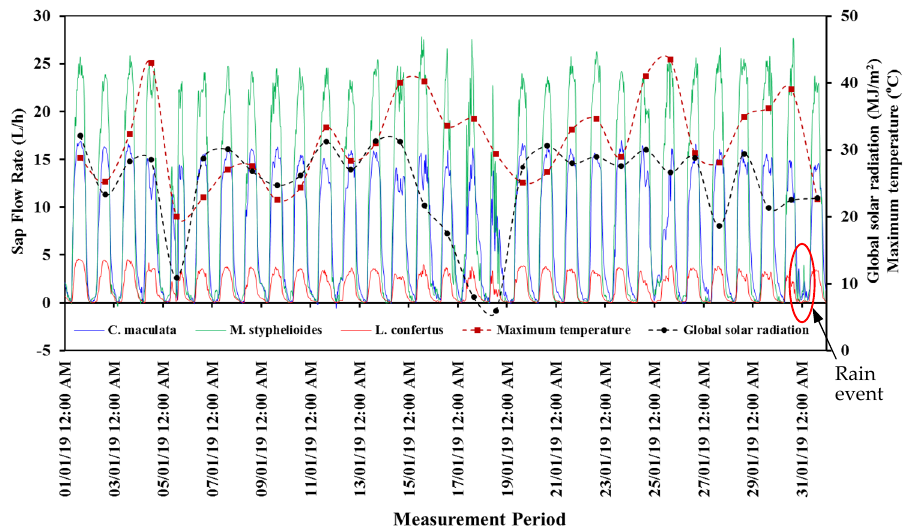
Figure 8. Comparison of sap flow rate against temperature and global solar radiation for the C. maculata , M. styphelioides and L. confertus used in these experiments.